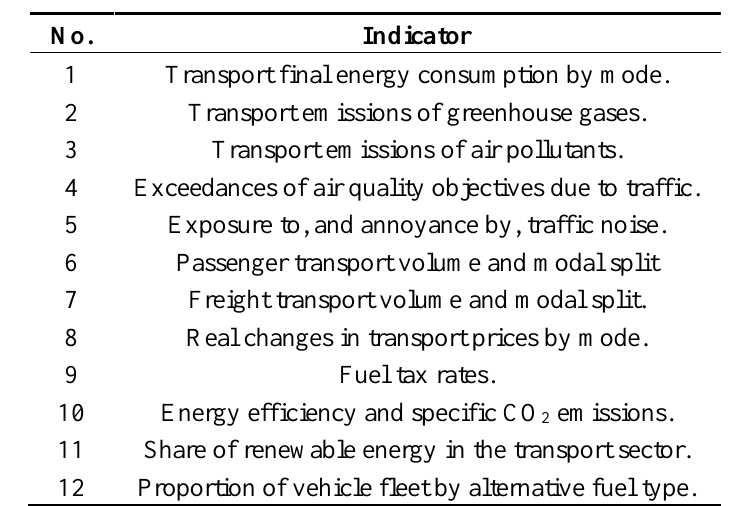
Table 1. List of the Transport and Environmental Reporting Mechanism Core Set of Indicators (TERM-CSIs) suggested by the European Environmental Agency (EEA).